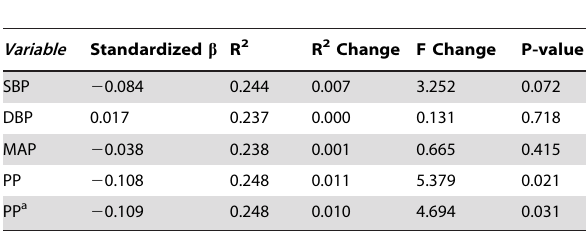
Table 4. Multivariable adjusted * relations between BP components and gait